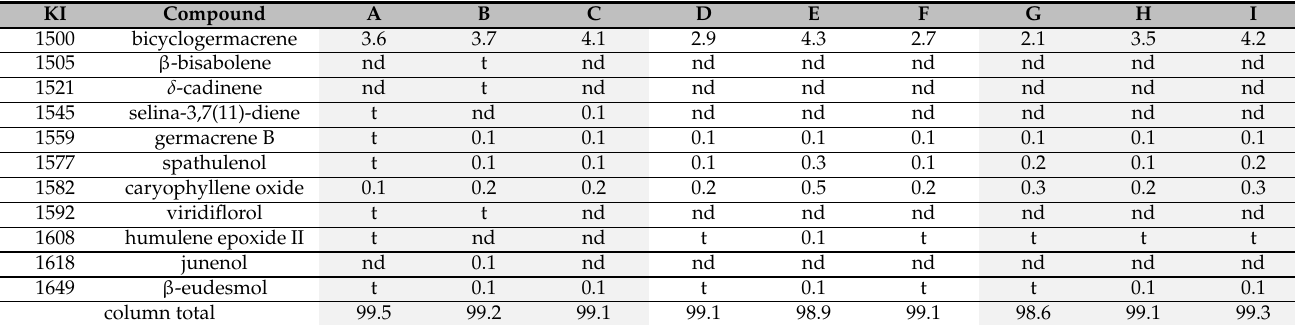
1 KI not previously calculated [32]. Manual calculation performed using alkane standards. Stable isotope ratios, δ 2 H and δ 13 C, were established for prominent compounds in essential oil samples. Prominent compounds are defined by the relative area % of a given compound being >5% for all samples from a region, including 1,8-cineole (samples D–I),